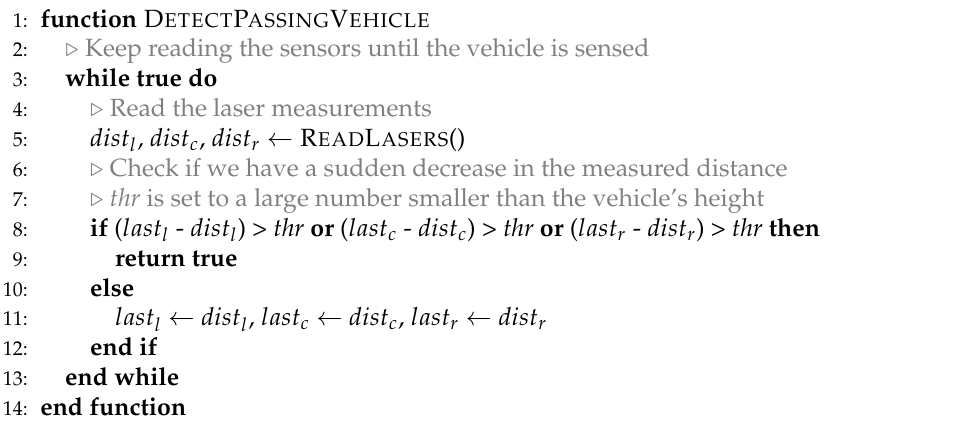
Algorithm 1: Approach for sensing the passing vehicle using three point lasers.